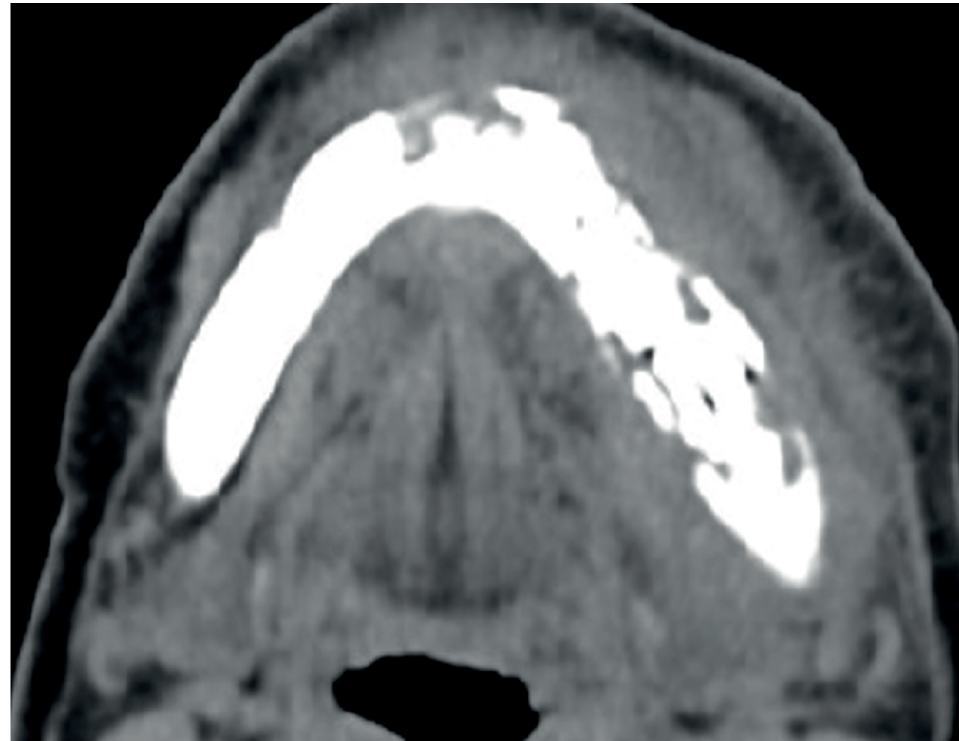
Figure 3. Computed tomography with contrast. Multifocal necrotic changes of the mandibular body in the mental sections and the left molar area.